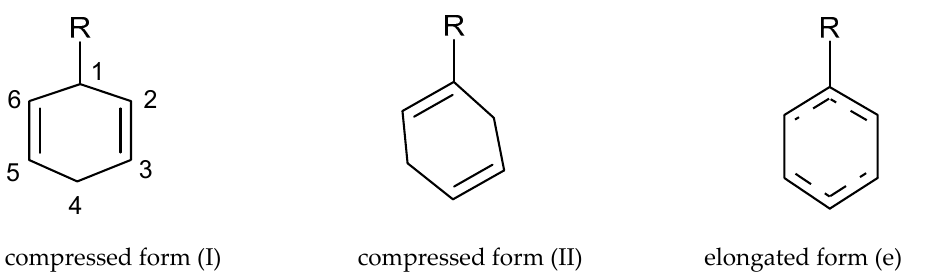
Scheme 1. Three forms of substituted benzene cation radicals calculated using the U- and RO-DFT approximations and the ω B97XD/aug-cc-pVTZ level.